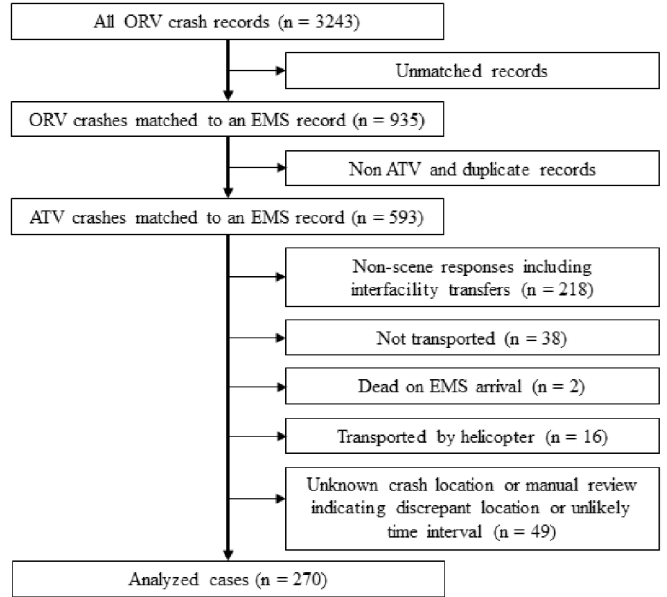
Figure 1. Flow diagram of stepwise inclusion (left) and exclusion criteria (right). Unlikely time interval was defined as total on scene time of zero. ORV: off-road vehicle; EMS: emergency medical services; ATV: all-terrain vehicle.